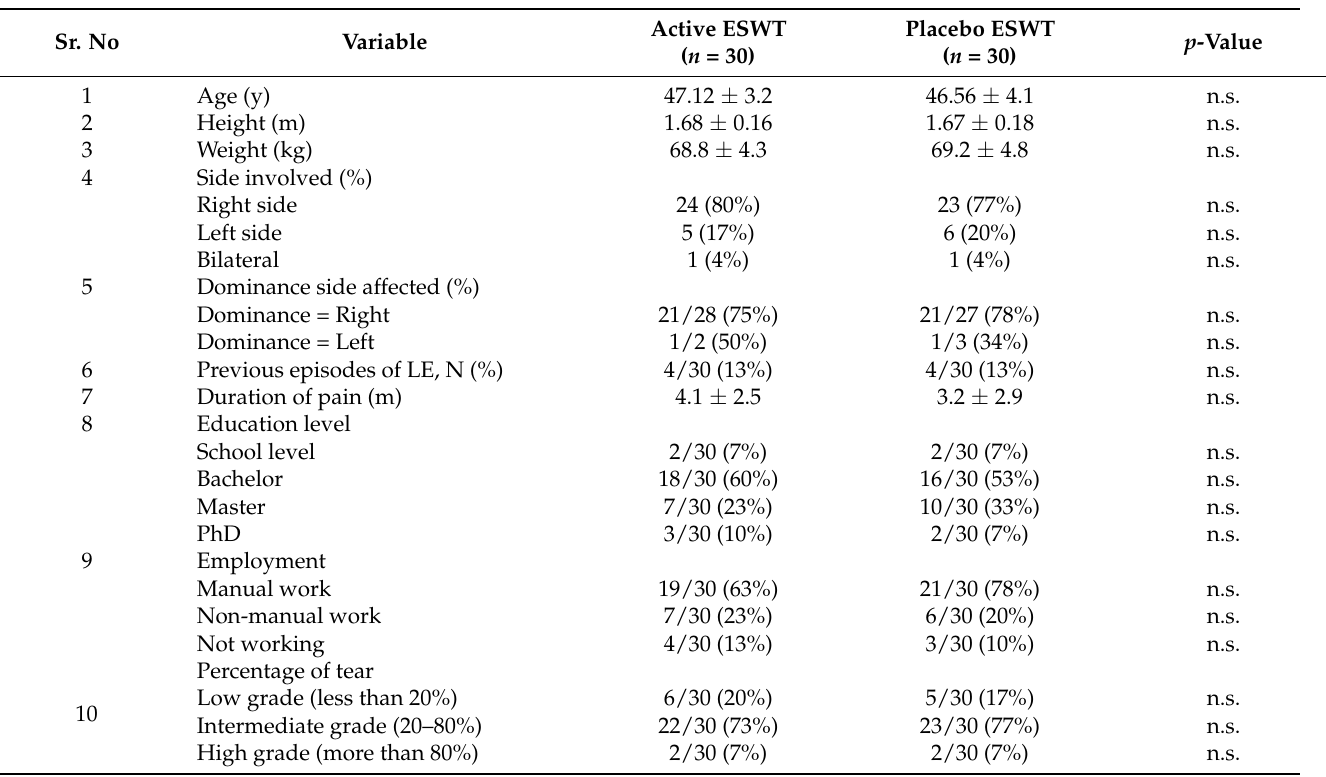
Table 1. Demographic and clinical characteristics of active and placebo ESWT groups.